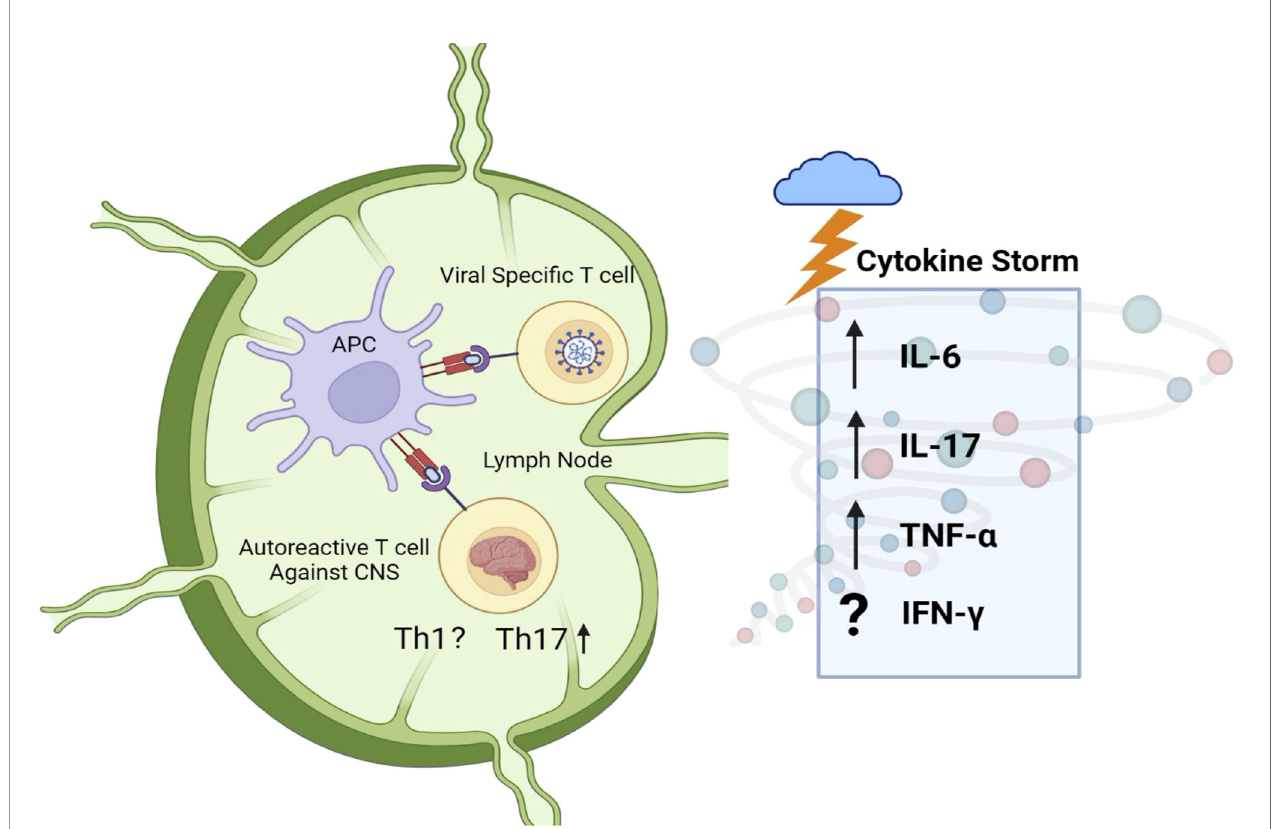
FIGURE 4 | Peripheral immune activation and molecular mimicry against myelin. The adaptive immune response to SARS-CoV-2 may result in the activation of CNS-autoreactive T cells as a result of molecular mimicry. Cytokine storm, observed in SARS-CoV-2 infected individuals, could then elicit the differentiation of CNS- antigen-speci fi c Th17 cells. The upregulation of IL-6, IL-17, and TNF- a is of particular interest, as these cytokines are heavily linked to MS and other demyelinating disorders in mouse and man such as NMOSD and EAE. Further research is needed to understand the Th1 response and generation of IFN- g in response to COVID- 19, as literature suggests mixed